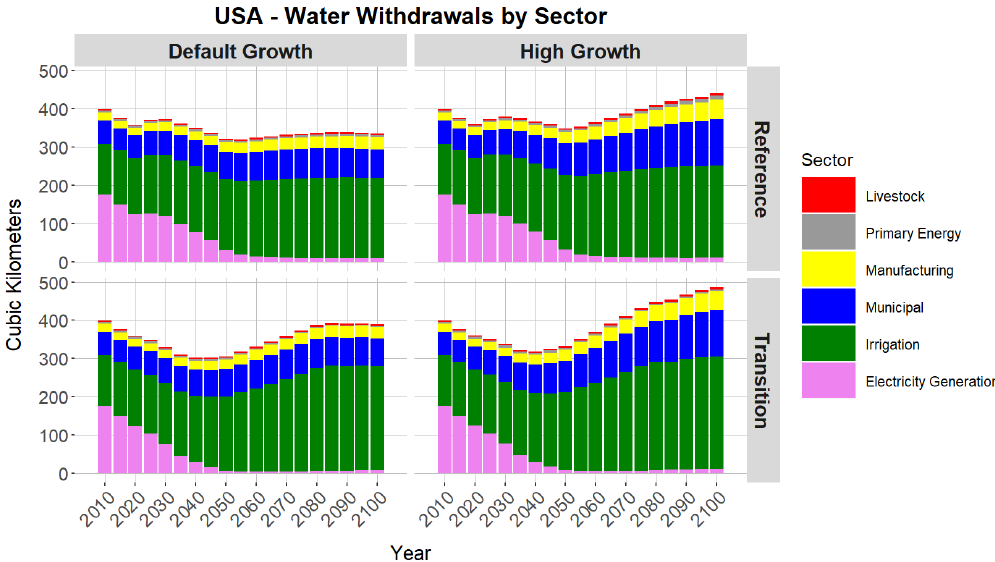
Figure 7. USA water withdrawals by sector and scenario. Columns reflect alternate assumptions about socioeconomic drivers; rows represent alternate assumptions about energy system